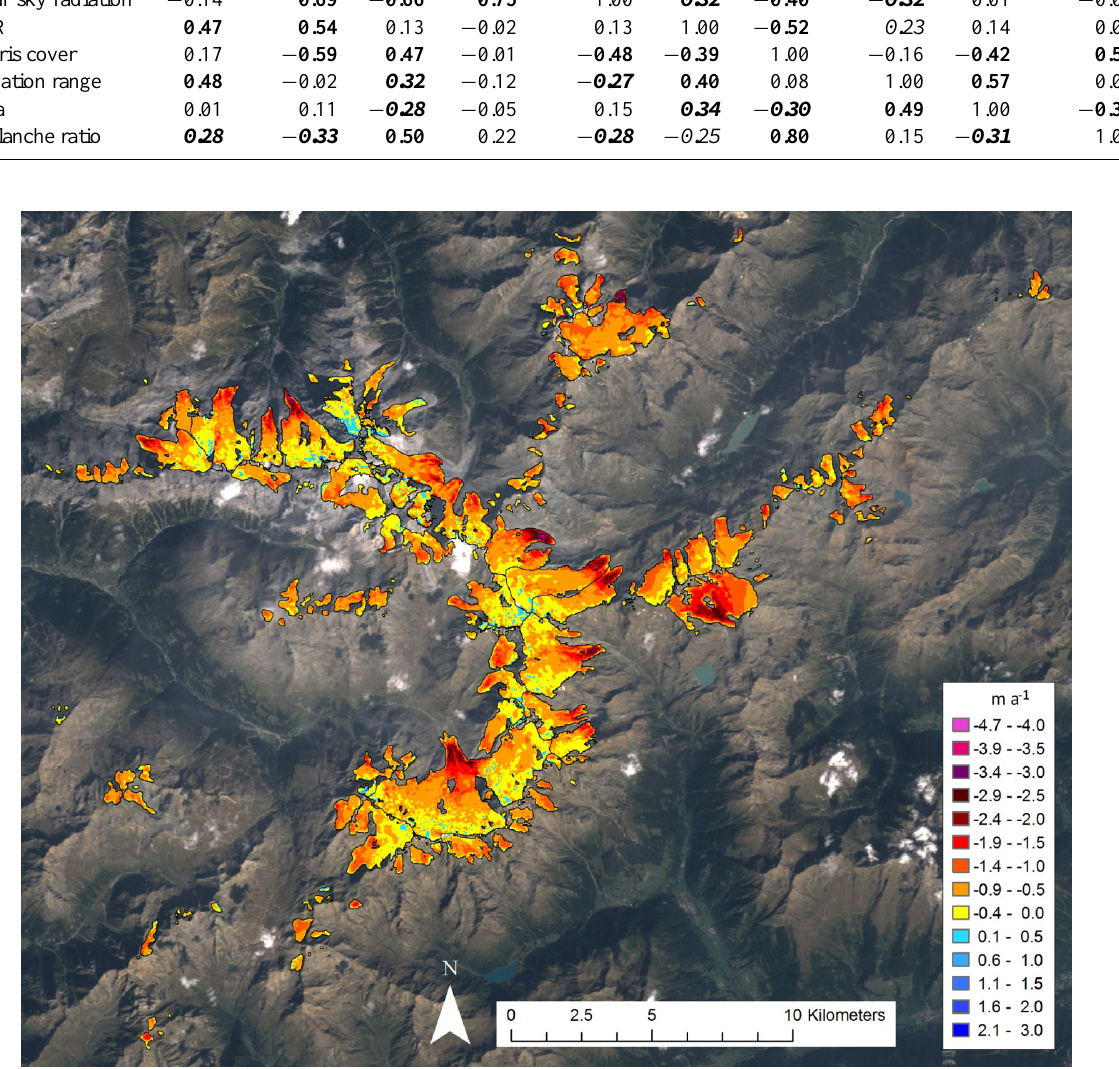
Fig. 9. Mean annual elevation change rates of the Ortles-Cevedale glaciers in the period from 1981–1984 to 2005–2007, on a cell-by-cell basis. with elevation and avalanche ratio are less significant